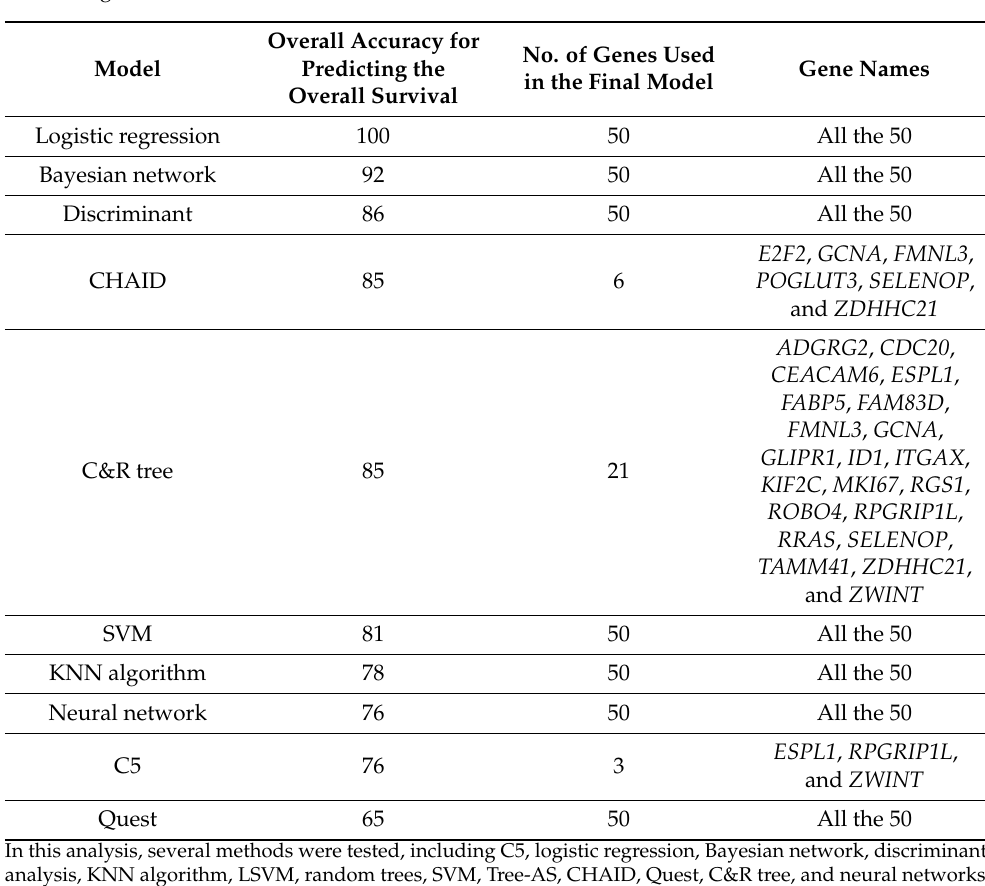
Table 4. Machine learning and neural network analysis of the combined Methods 1 and 2 with the MCL35